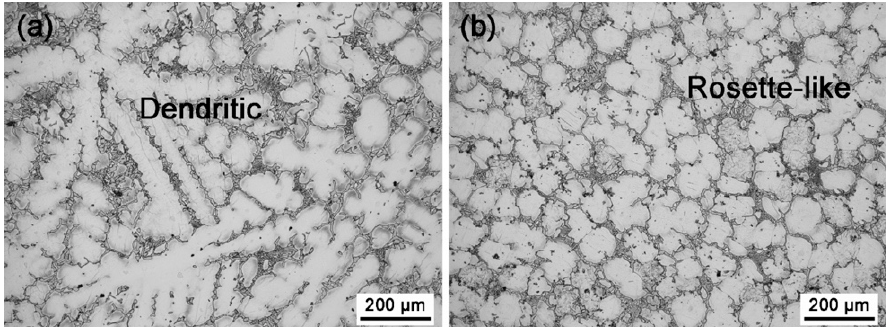
Figure 3. OM images of the Mg–Al–Gd alloys homogenized at 620 ◦ C and furnace-cooled under ( a ) 0 T